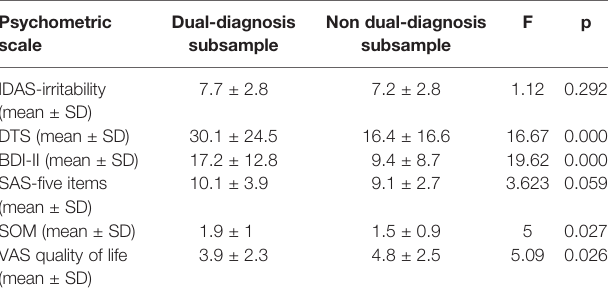
TABLE 7 | ANOVA results comparing dual diagnosis and non-dual diagnosis participants. Psychometric scale